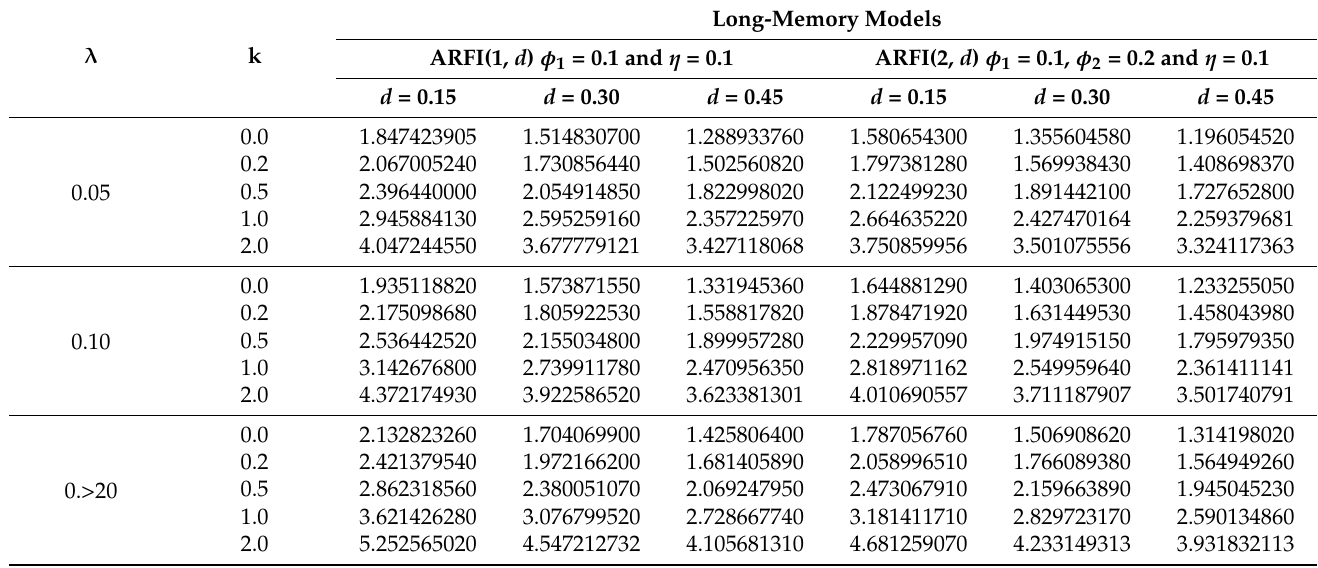
Table 1. The UCL (H) values for the modified EWMA control chart for ARL 0 =